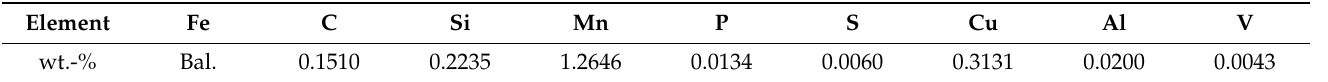
Table 1. Cast analysis of S355 J2C + C according to the datasheet of the manufacturer. Element